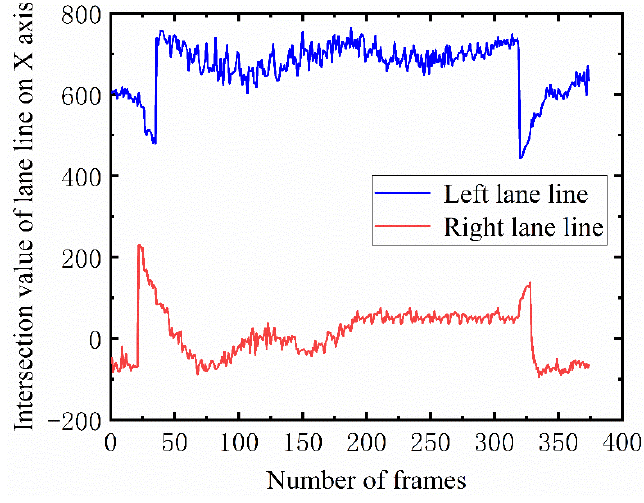
Figure 6. Value of the intersection of the left and right lane lines on the x-axis.